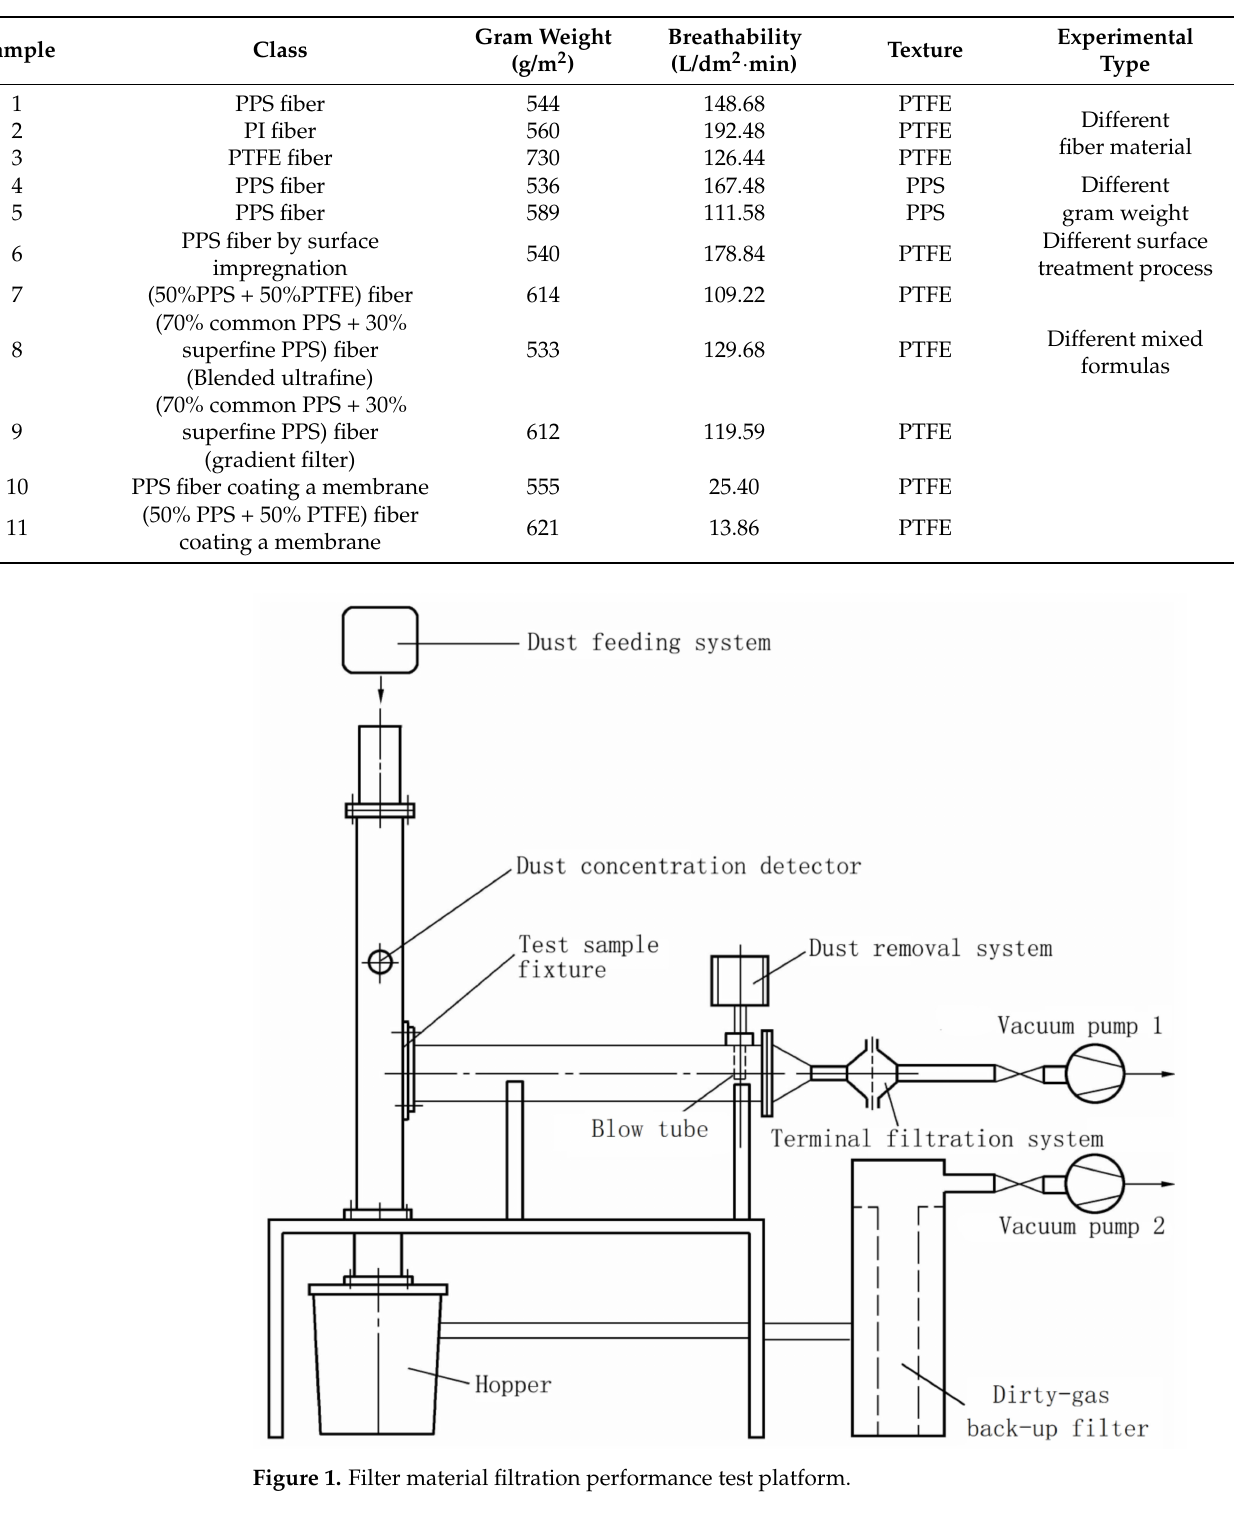
Table 1. Basic parameters of the experimental sample.